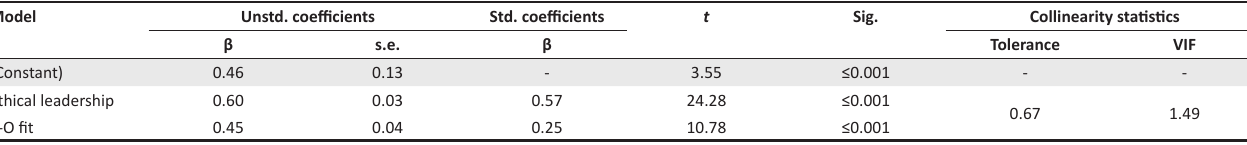
TABLE 4: Results of stepwise multiple regression analysis – assessment of the relative predictive strength of the independent variables (ethical leadership and P-O fit), as well as multicollinearity between them. Model